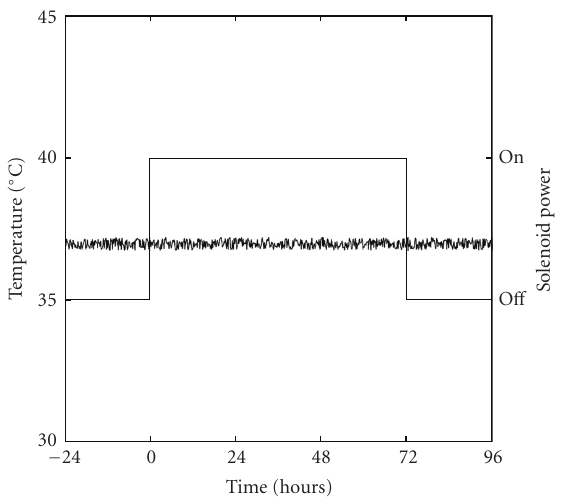
Figure 1: Temperature monitoring of exposed samples over time . Direct monitoring of treated sample temperatures before, during and after exposure was performed using a digital multimeter (METEX Mod. M-3630D) equipped with ScopeView software (vers.